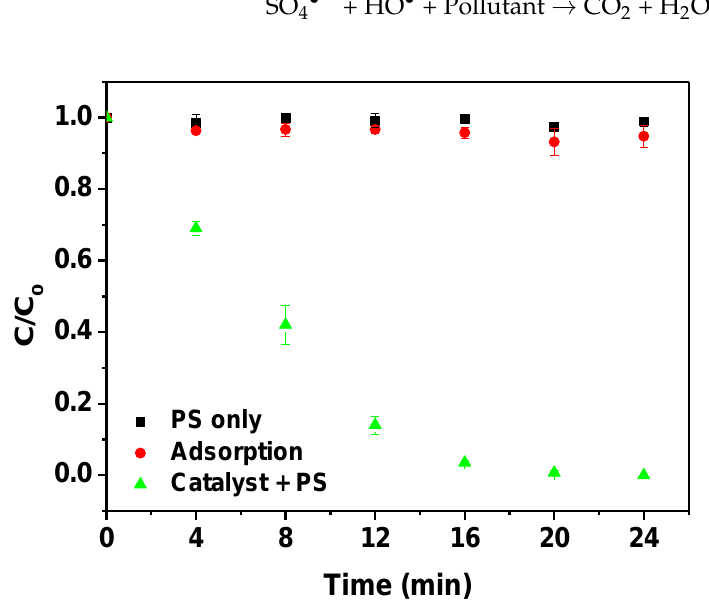
Figure 4. Control experiment for oxytetracycline (OTC) degradation ([PS] 0 = 1 mM, [OTC] 0 = 20 µ M, [HWWC] 0 = 0.2 g/L, pH = 6). PS: persulfate; HWWC: hand-warmer waste catalyst.